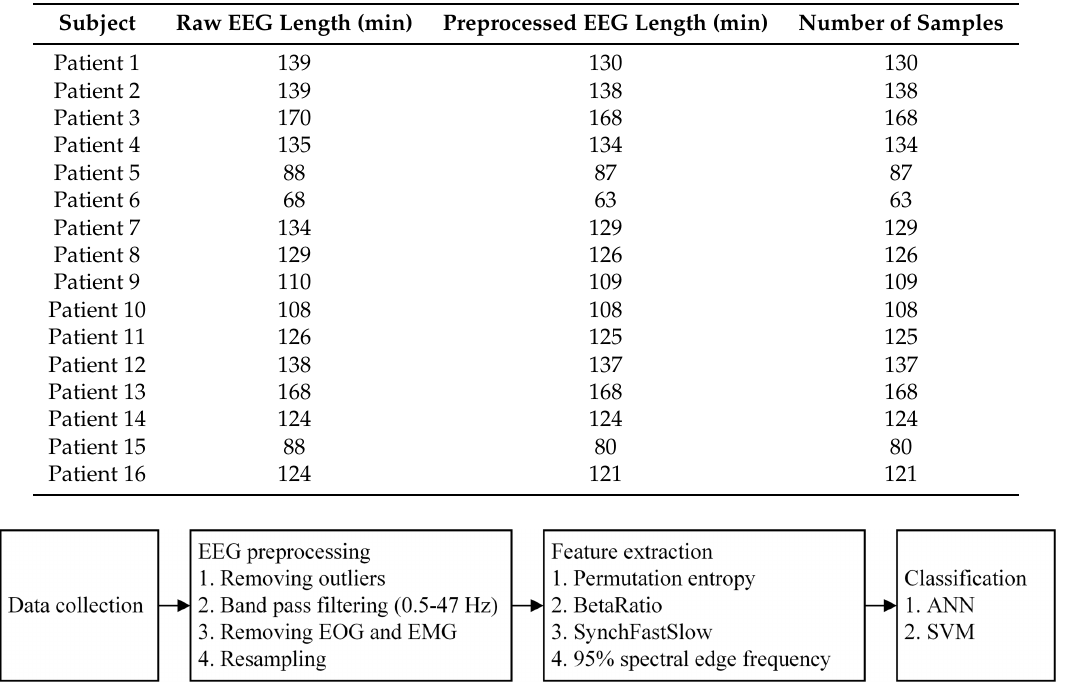
Figure 1. The flow chart of EEG